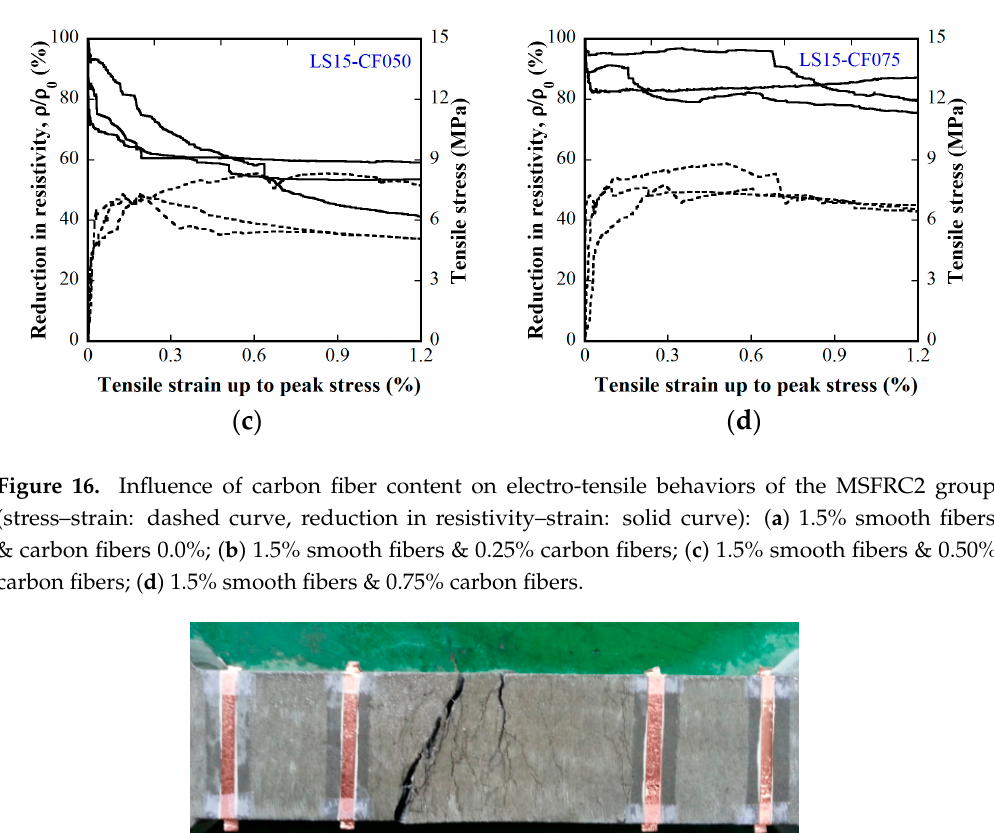
Figure 18. Comparative gauge factors of studied MSFRCs: ( a ) for MSFRC1 group; ( b ) for MSFRC2 group.